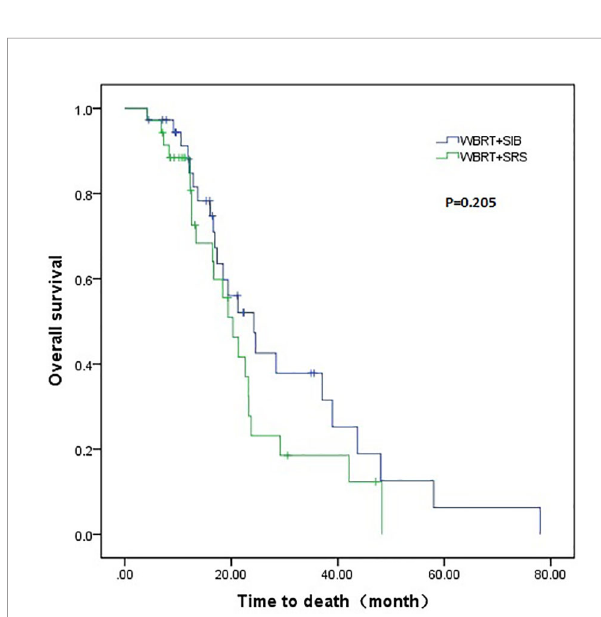
FIGURE 2 | Comparison of overall survival between WBRT + SIB and WBRT + SRS.